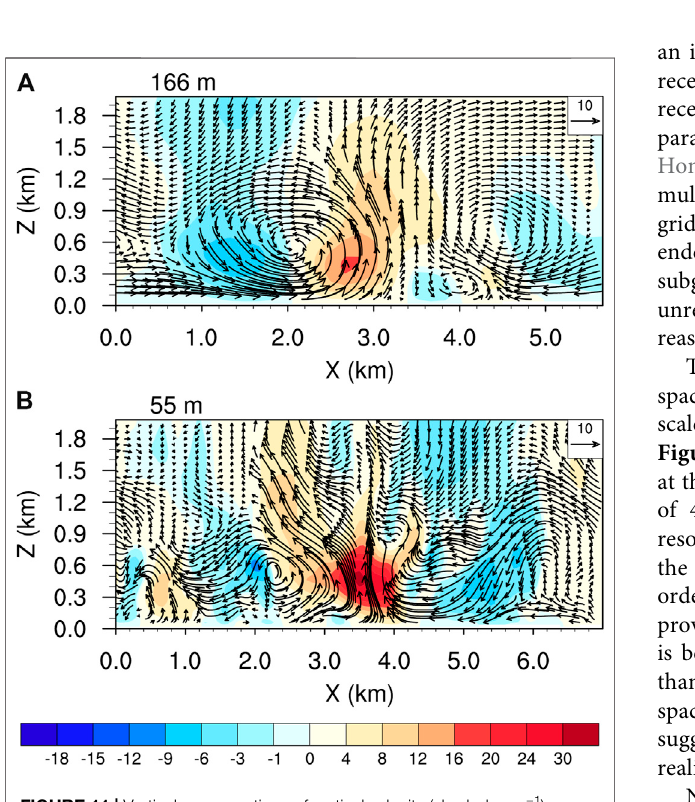
Frontiers in Earth Science |